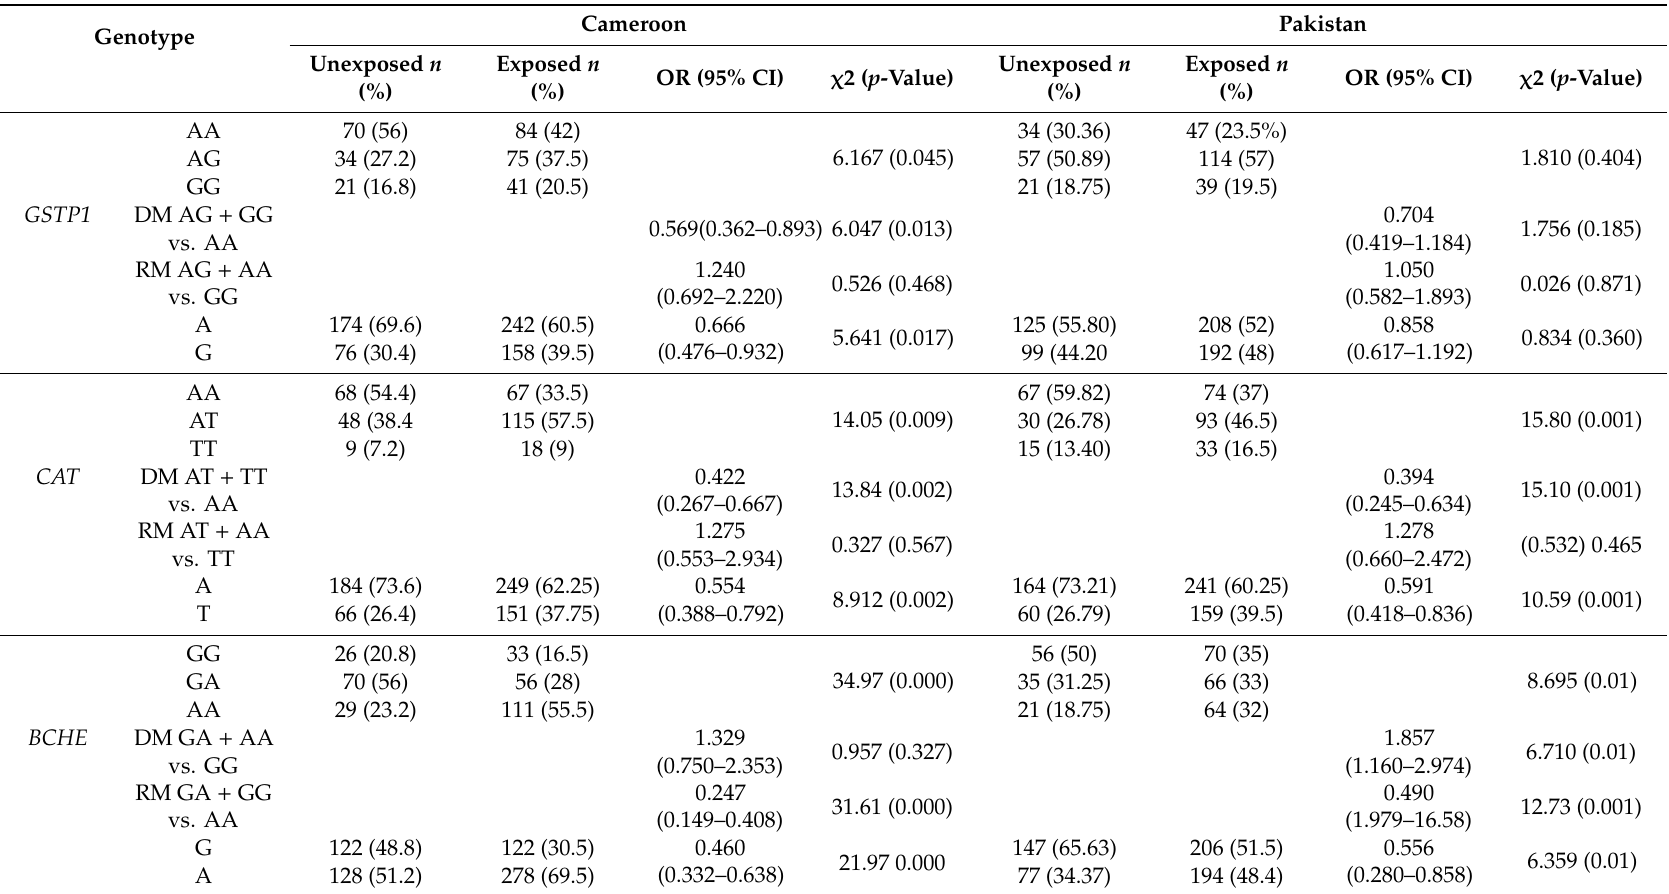
Table 4. Genotypes and Alleles frequencies in unexposed and OP-exposed